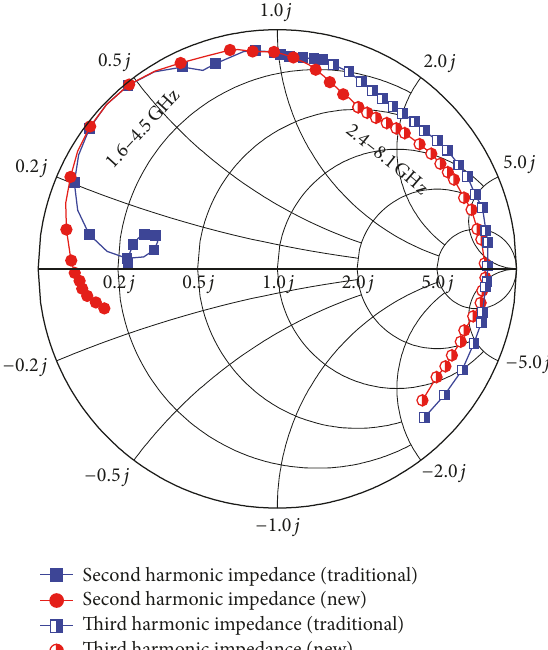
Figure 3: Parasitic compensation of fundamental impedance.